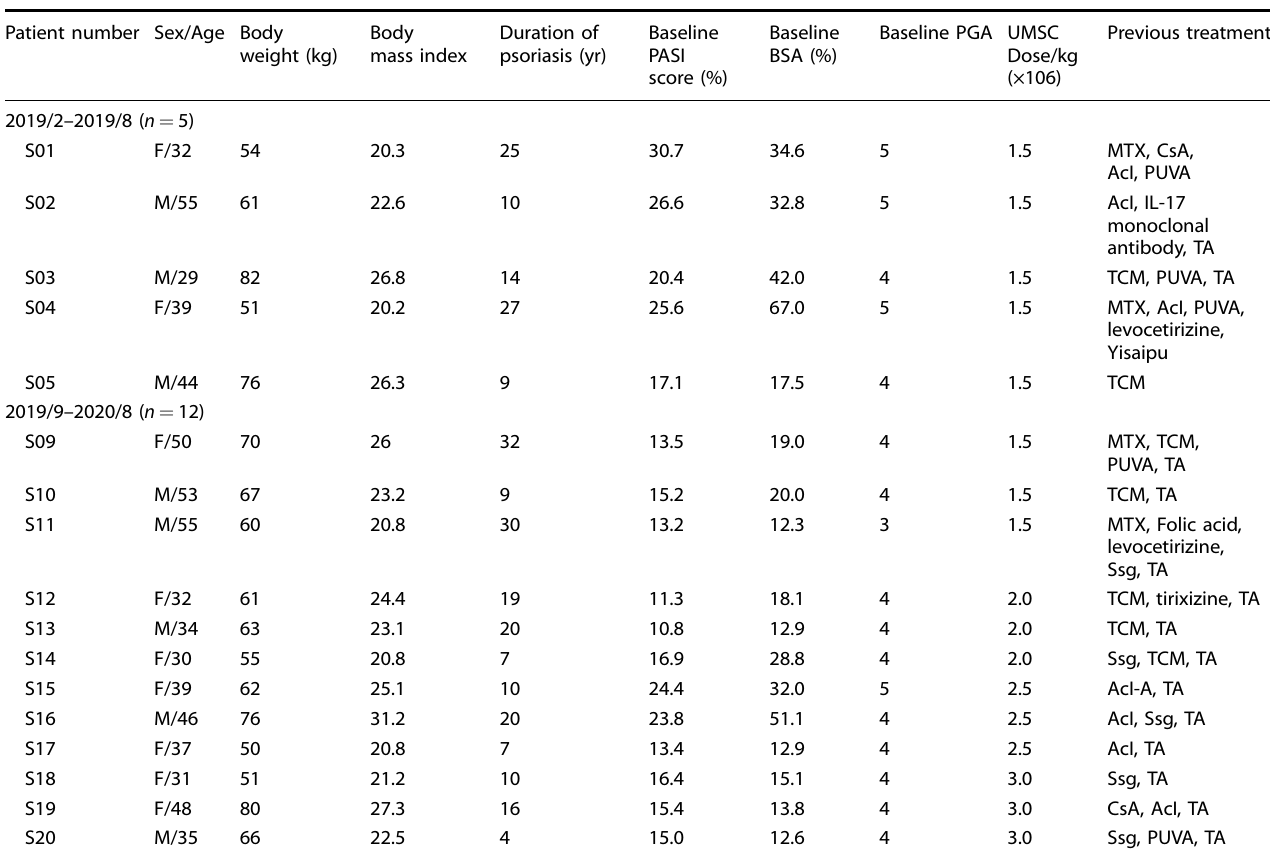
Table 1. Baseline characteristics of the patients Patient number Sex/Age Body weight